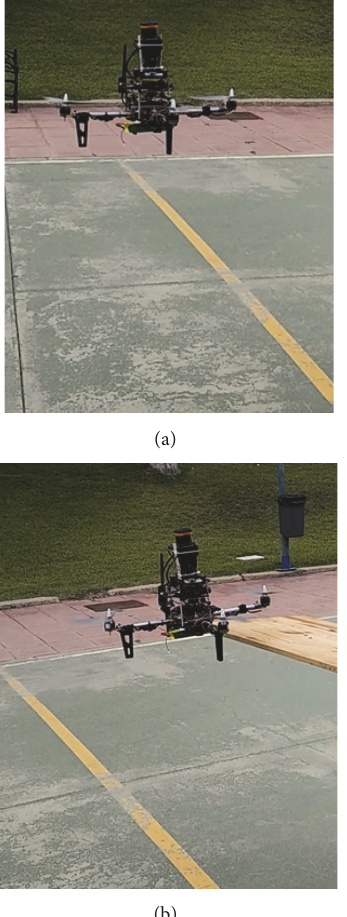
Figure 29: Partial ground effect tests with multirotor flying out- doors:(a)multirotorinfreeflight;(b)multirotorflyingunderpartial ground effect (the rotor at the right with a ground plane close to it).